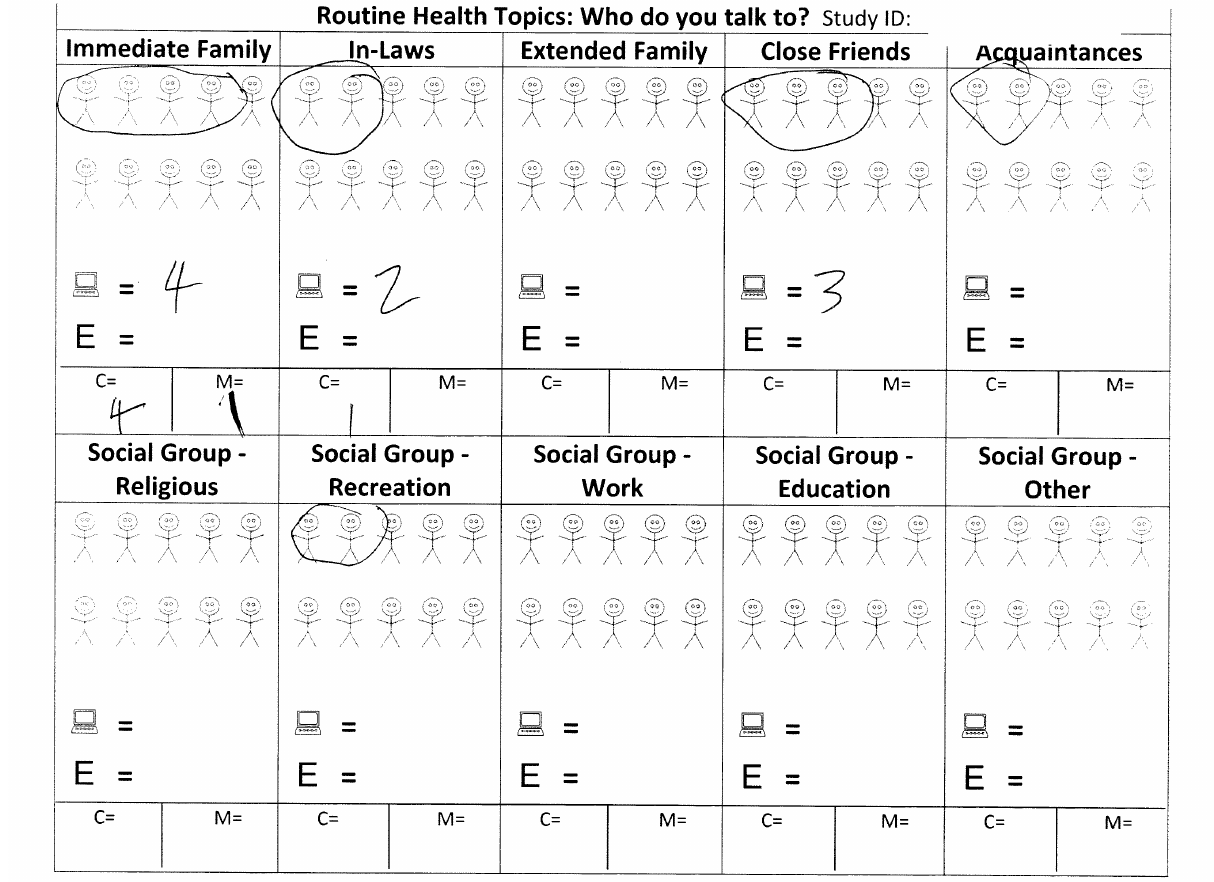
Figure 2. Health communication network tool. Study participants were provided with blank worksheets and asked: “Please mark one stick figure for each person you can think of that you communicate with about routine health topics…these are people you would communicate with about routine health topics like cancer screening, vaccine shots, diet, or exercise.” The worksheet was used to facilitate the estimation of the number of emails or postcards promoting colorectal cancer screening that they would send to members of their social